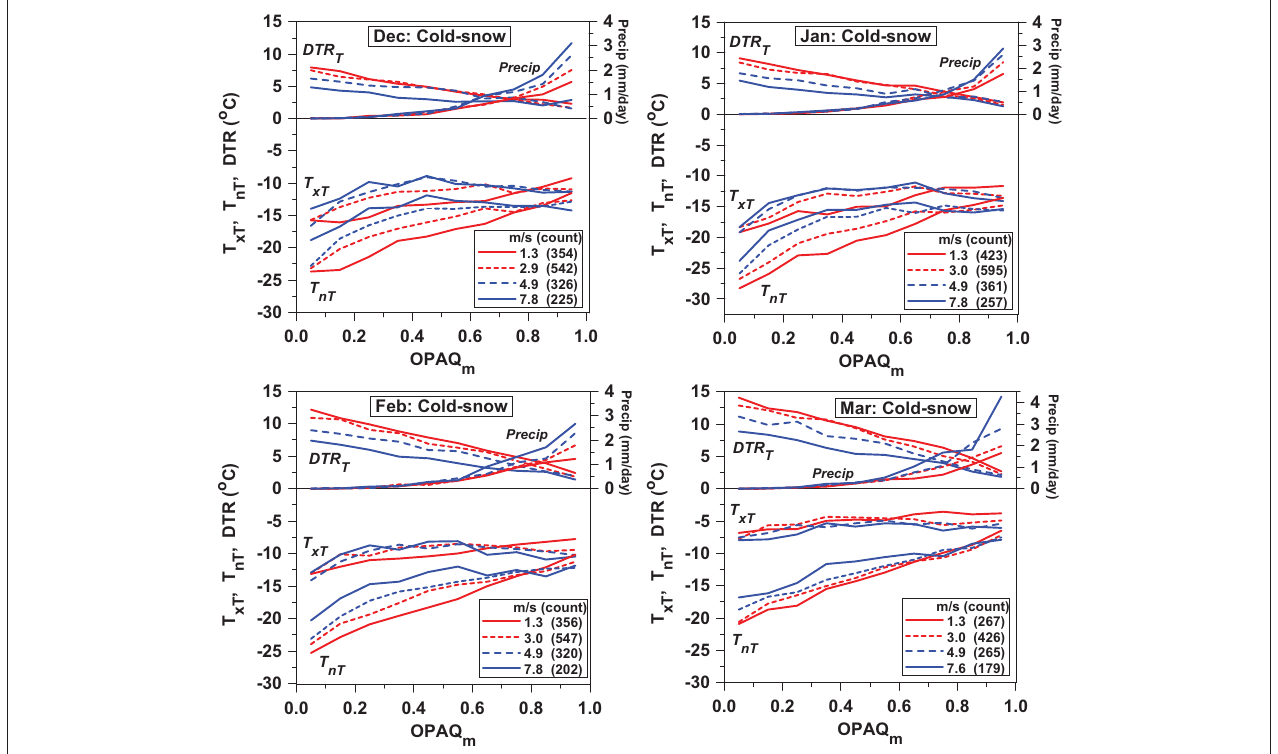
FIGURE 20 | T x , T n , DTR, and precipitation as a function of OPAQ m partitioned into four classes of daily mean windspeed, < 2, 2–4, 4–6, and > 6 m/s, for the months December to